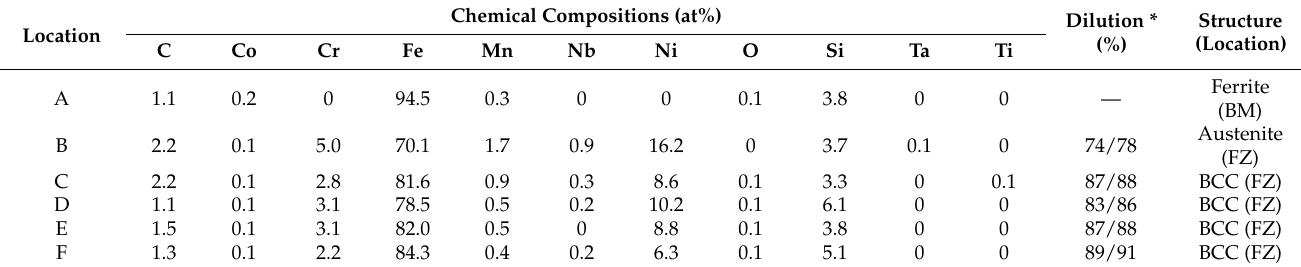
Table 1. Dilution and quantitative WDS chemical analyses in Figures 4a and 7a. Location